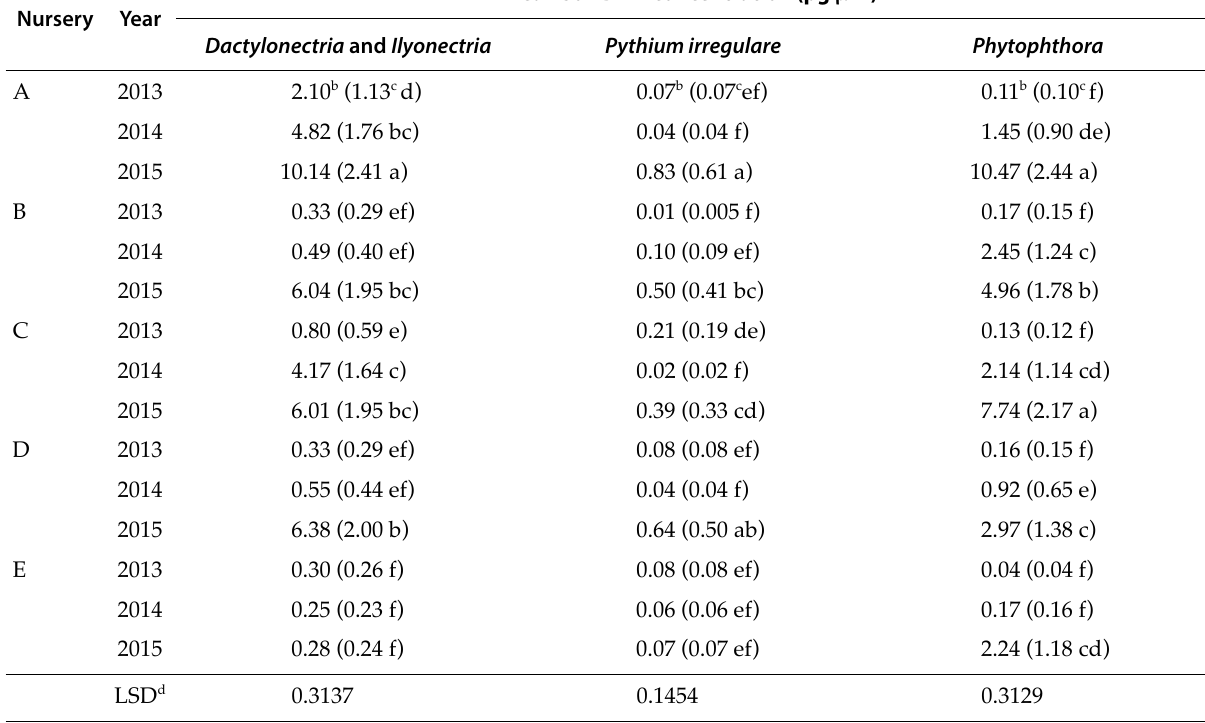
Table 4. Mean Dactylonectria and Ilyonectria , Pythium irregulare and Phytophthora DNA concentrations in soil, determined with quantitative real-time PCR analyses of soils from five grapevine nurseries sampled over 3 years. Mean soil DNA concentration (pg μL -1 ) a Nursery Year Dactylonectria and